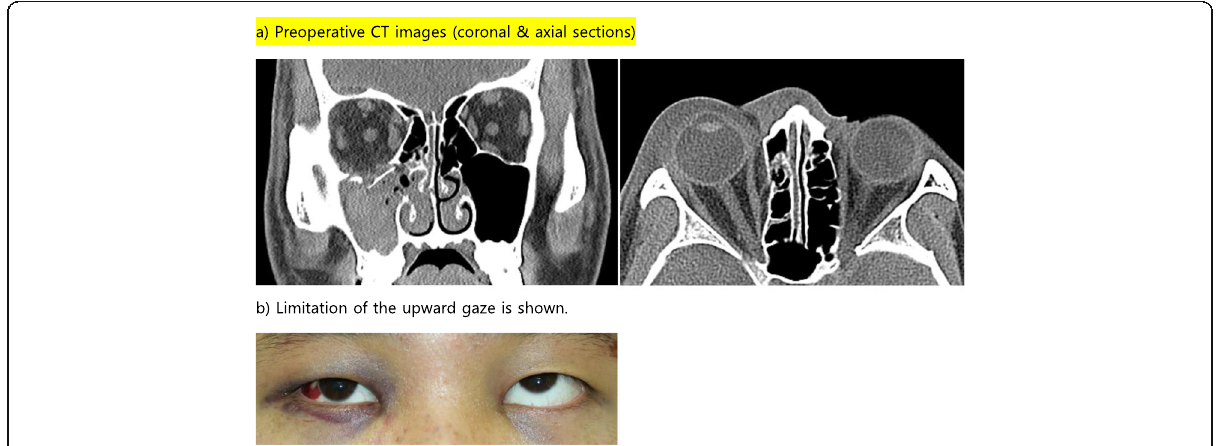
Fig. 4 a Preoperative CT images (coronal and axial sections). b Limitation of the upward gaze is